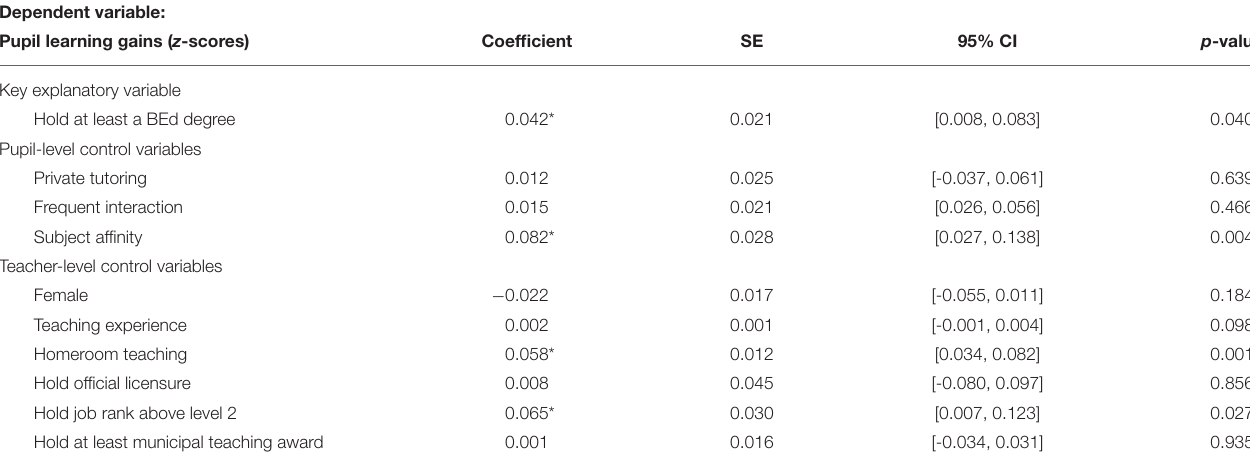
TABLE 3 | Pupil fixed-effect regression results ( n = 15,096). Dependent